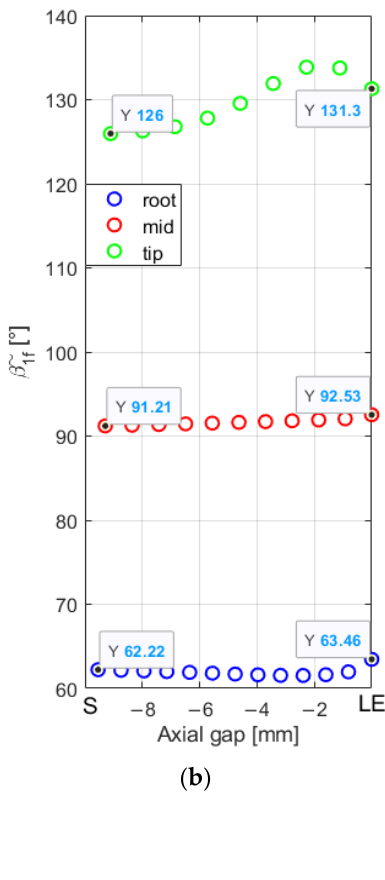
Figure 11. Unaveraged input relative velocity angle distributions at the bucket leading edge plane and pneumatic probe plane.